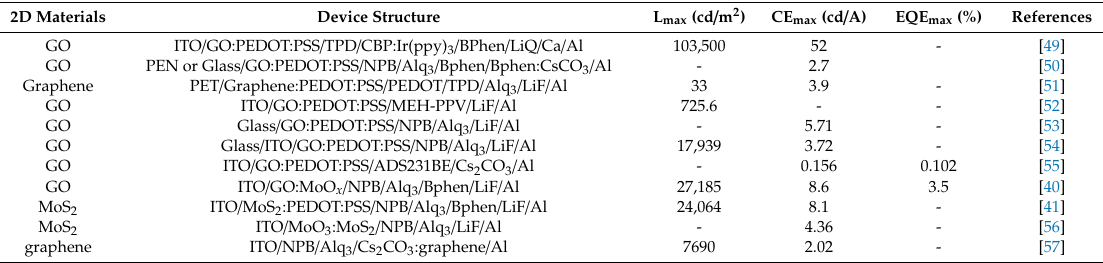
Table 2. Summary of the device parameters of OLEDs with composite layer doped with 2D materials. 2D